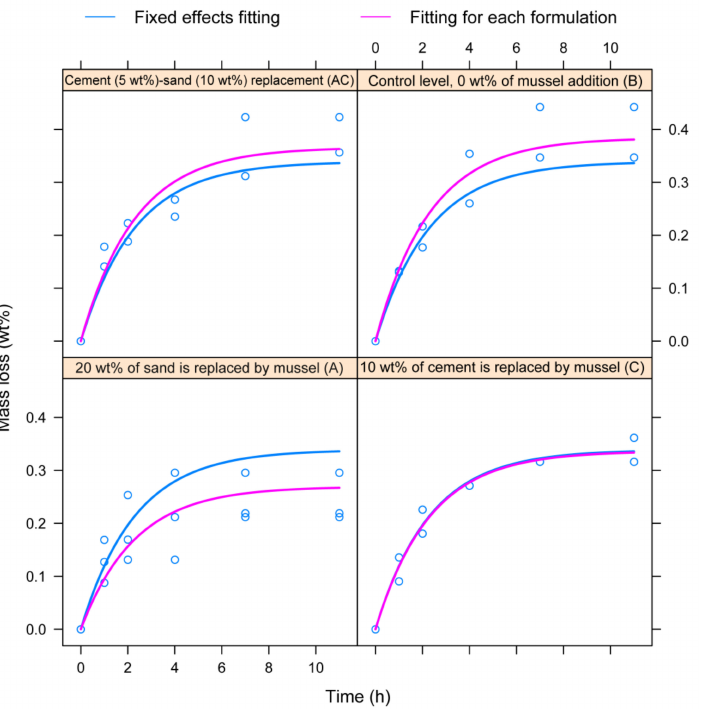
Figure 14. Graphical output of the mixed effect nonlinear asymptotic regression model. The fitting to the mass loss vs. time using all the observations is blue, whereas the fittings including the random effect for each concrete formulation are in